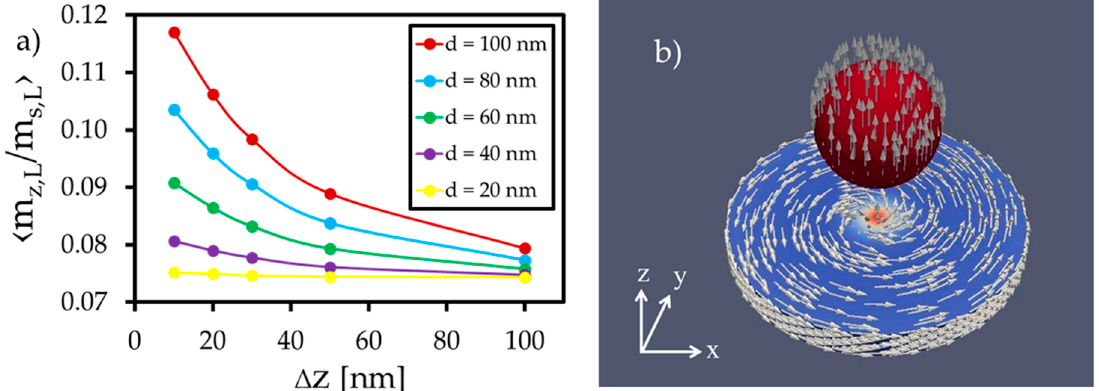
Figure 4. ( a ) Averaged z-component of the free layer magnetization during the simulation of different particle diameters placed in different heights in the center above the free layer. ( b ) Magnetization orientation of the magnetic vortex and the magnetized label after reaching the steady state of the simulation.